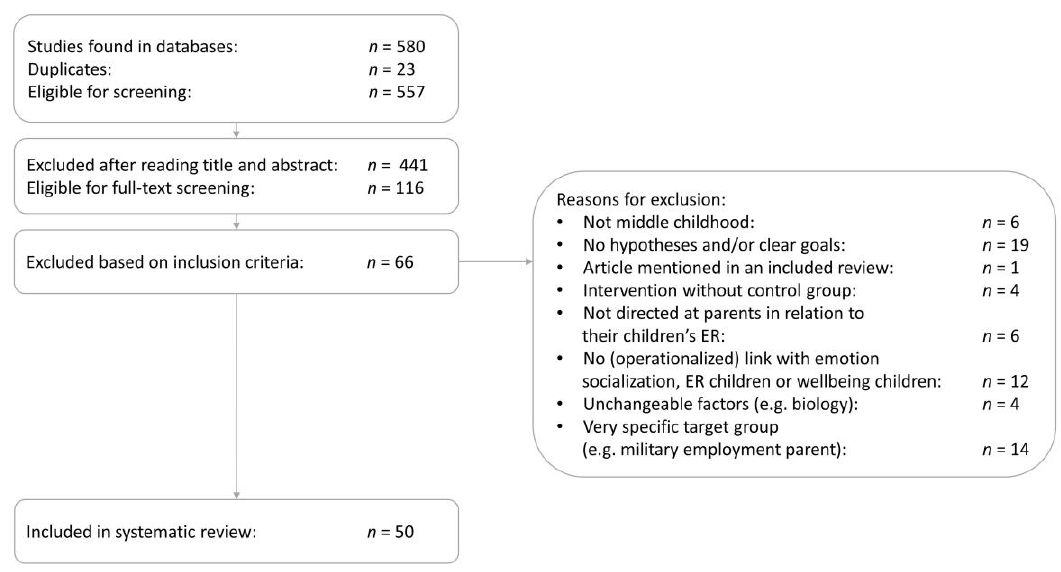
Figure 2. Flow chart of the screening process.